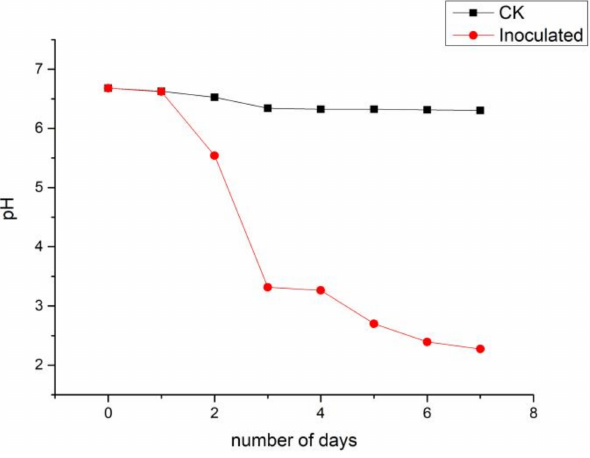
Figure 4. The ability of the strain to disintegrate phosphorus from di ff erent sources. ** showed significant di ff erence between the treatment group and the control group after a t test ( p < 0.01).